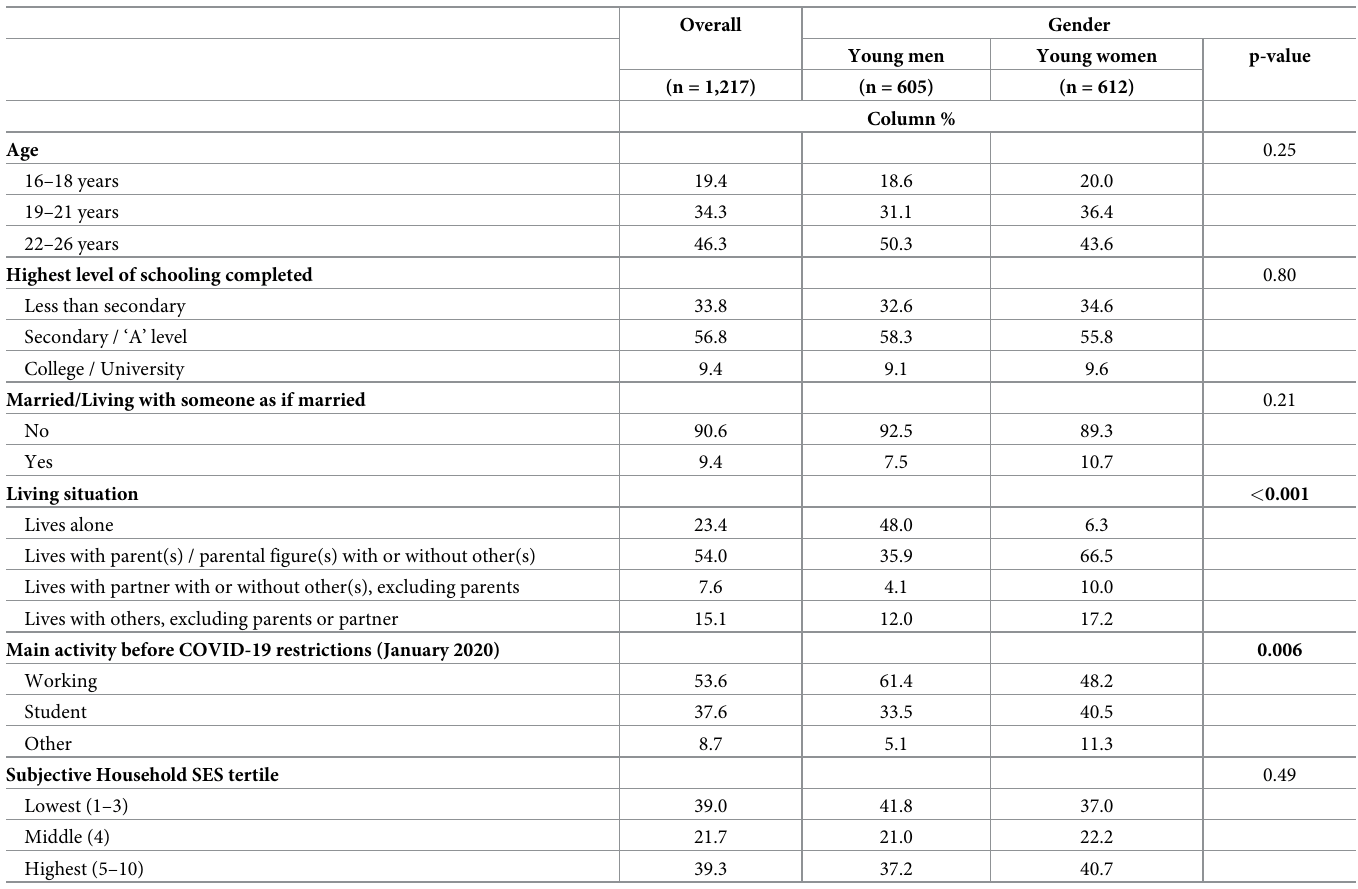
Table 1. Participant demographics, overall and by gender, weighted (n =